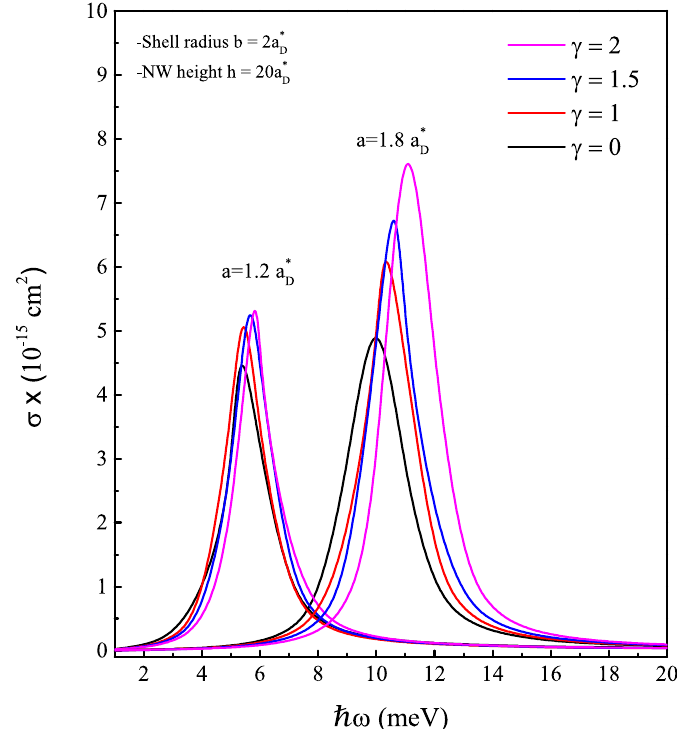
Figure 9. On-center donor impurity related photoionization cross-section coefficient in cylindrical Al x Ga 1 − x As/GaAs-based core/shell NW as a function of the incident photon energy for two typical core radiuses a = 1.2 a ∗ and 1.8 a ∗ . We take the following magnetic field strength: γ = 0, 1, 1.5 and D D